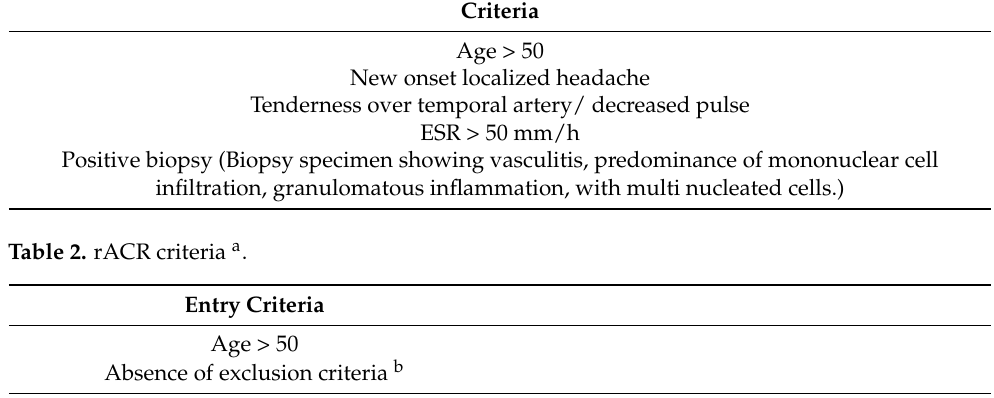
Table 1. ACR criteria.